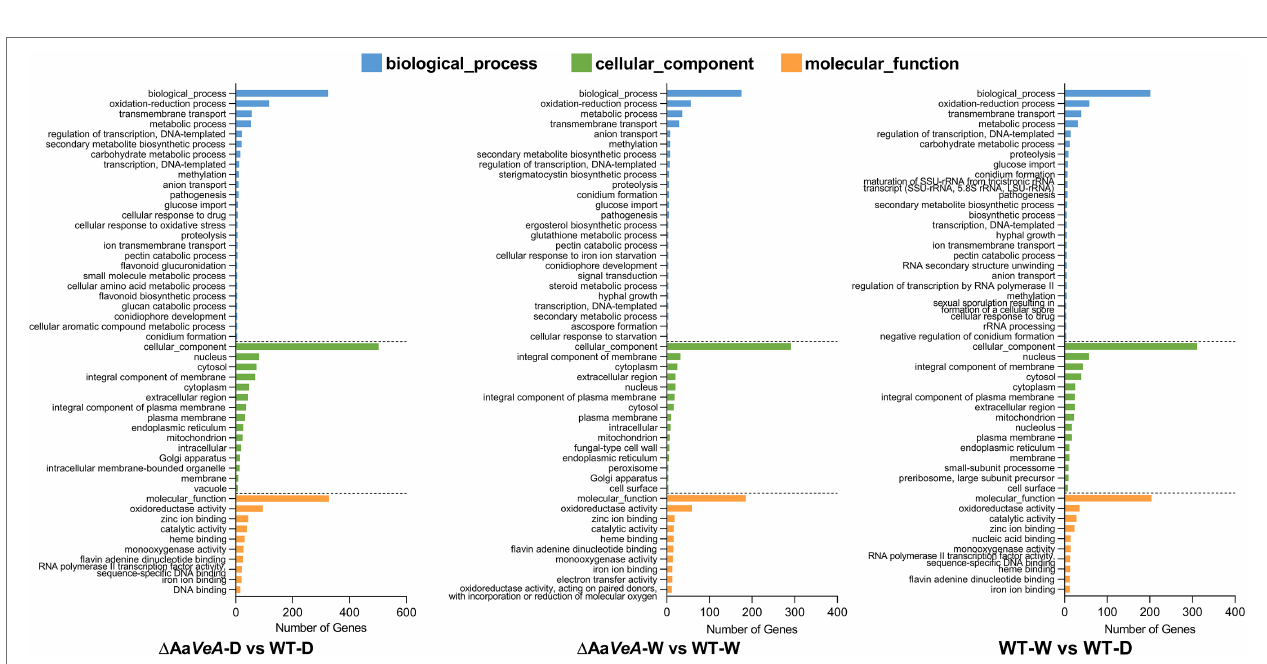
FIGURE 3 | Mycotoxin biosynthesis produced by the WT and Aa VeA disrupted mutant ( Δ Aa VeA ) strain of Alternaria alternata under various light sources. The concentrations of mycotoxins, including tenuazonic acid (TeA; A ), alternariol (AOH; B ), and alternariol monomethyl ether (AME; C ), were, respectively, extracted and determined by LC–MS.